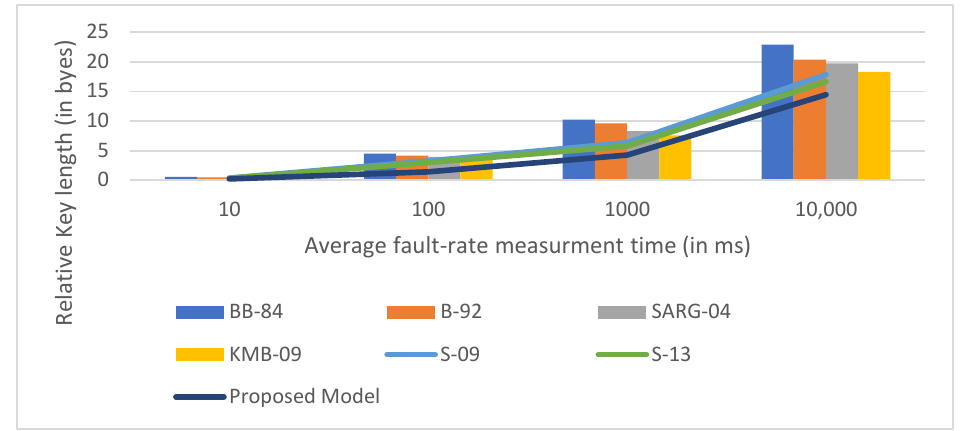
Figure 8. Comparison of the proposed model to the existing models in terms of average fault rate measurement time .